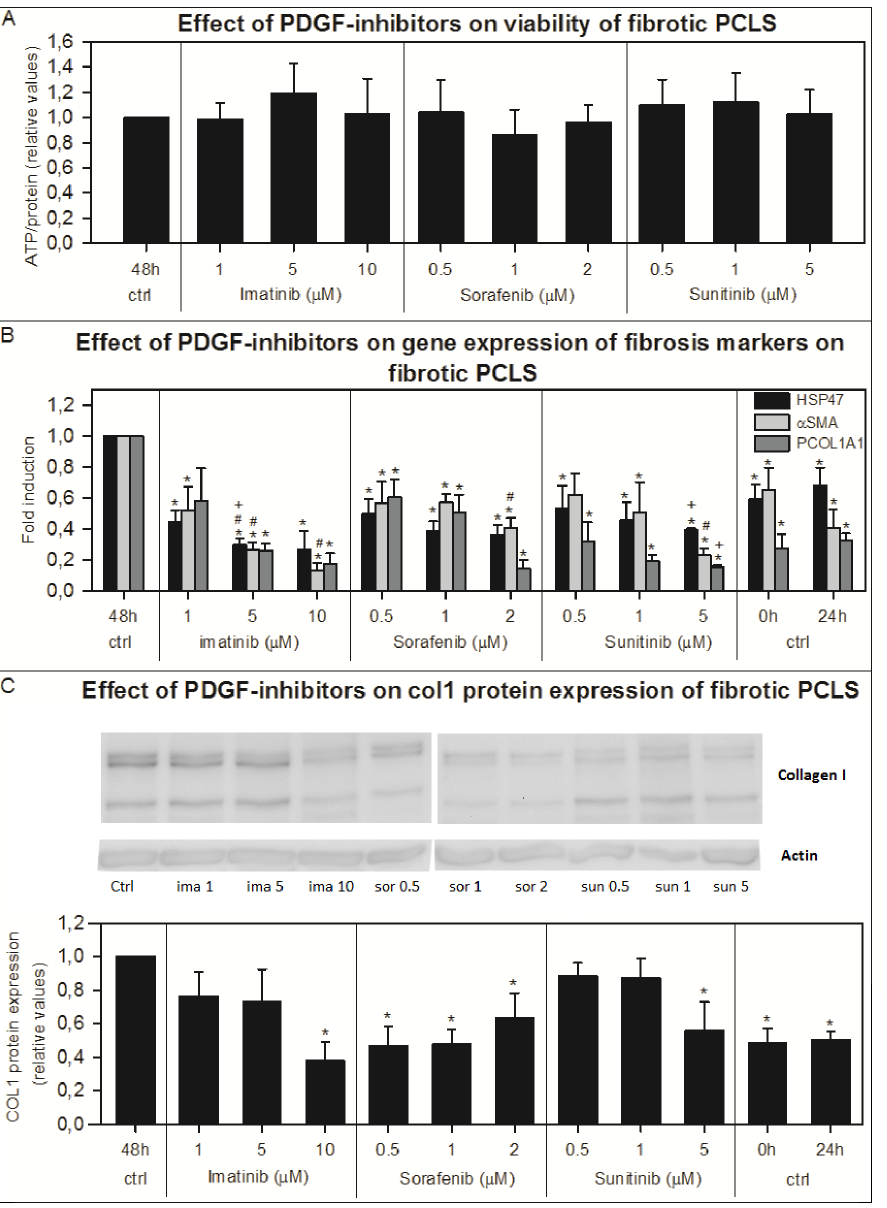
Figure 4. The effect of PDGF-inhibitors in fPCLS on viability, gene expression of fibrosis markers and collagen 1 protein expression. The effect of PDGF-inhibitors imatinib (n=4), sorafenib (n=4) and sunitinib (n=4) on the viability (A), on the gene expression of fibrosis markers Hsp47 , a Sma and Pcol1A1 (B) and on the collagen 1 protein expression (pictures are from a representative experiment) (C) of fibrotic PCLS from livers from BDL rats incubated for 48 hours. Error bars represent SEM. Significant decrease: *p , 0.05 vs 48h, # p , 0.05 vs 0 hours, + p , 0.05 vs 24 hours.